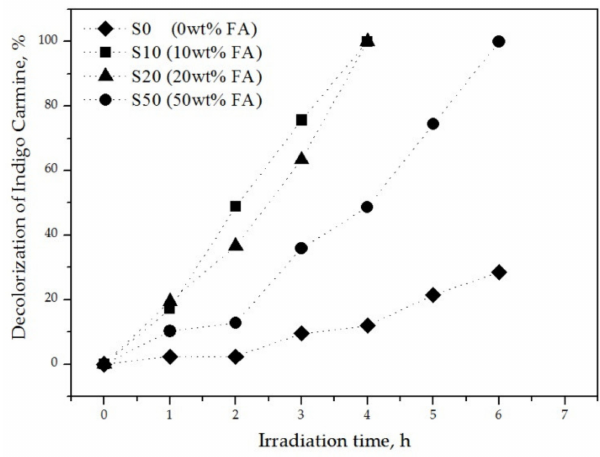
Figure 8. Decolorization (%) of IC solution as a function of irradiation time (h) for all coated